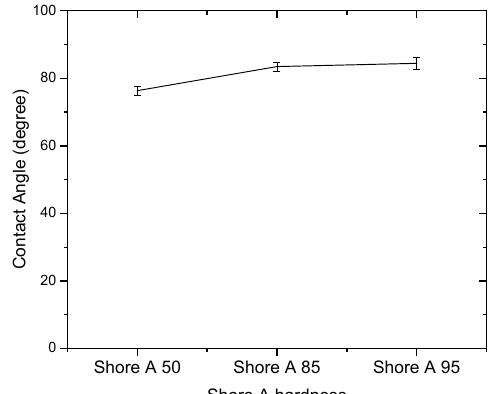
Figure 2. Contact angles of distilled water on substrates with different Shore A hardness values.